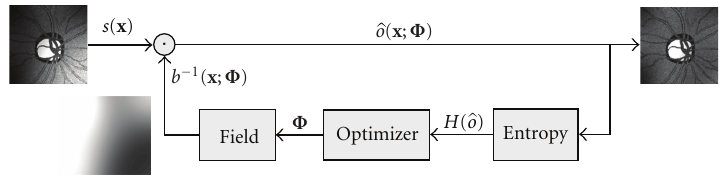
Figure 6: Flow diagram of iterative optimization algorithm.